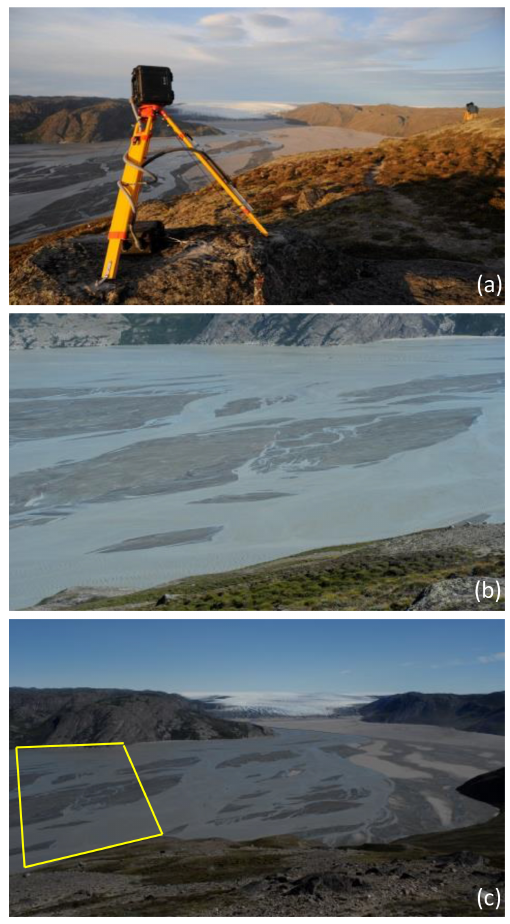
Figure 1. Figure 1 shows example images taken on 17 July 2012 of the Isortoq River by the two camera systems as well as the cameras themselves (foreground and background, panel a ). The Issunguata Sermia Glacier is seen in the background, and nearly all water in this river is derived from its melting terminus. Only the wide fo- cus camera (c) has a continuous data record from 2011 to 2012, as a presumed Arctic fox severed the wiring on the narrow focus camera (b) . The yellow polygon in the wide focus image shows the target reach for W e extraction, covering an area of approximately 1000m ×